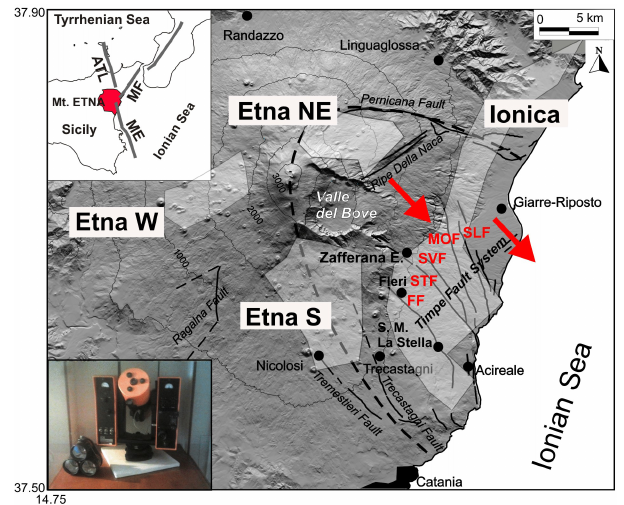
Figure 1. Surface faults map of Mt. Etna. Top inset map shows the main regional fault systems: MF is Messina–Fiumefreddo, ME is Malta Escarpment, and ATL is Aeolian–Tindari–Letojanni. Dashed line defines the sliding sector and red arrows indicate its movement direction. White areas are covered by EDM networks. In the bottom insert, the AGA 6BL laser